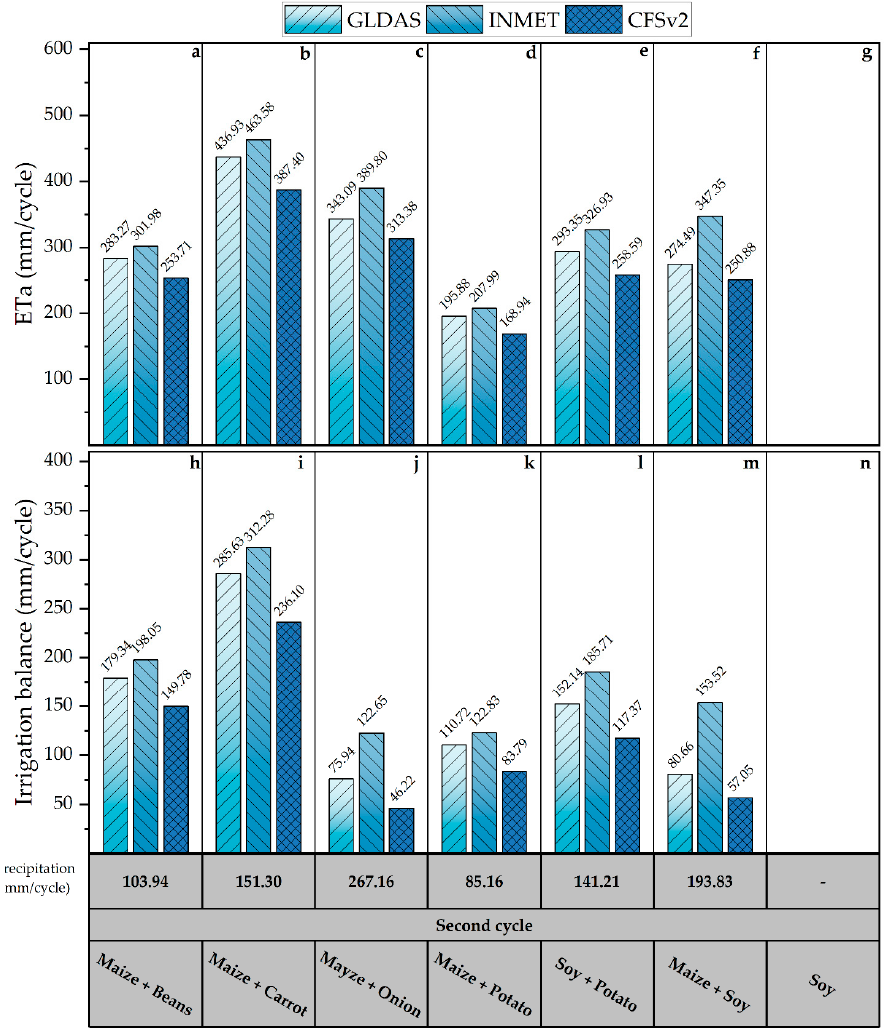
Figure 11. Average accumulated evapotranspiration ( a – g ) and precipitation and irrigation balance ( h – n ) of the second cycle of the classes ( a – n ). The second cycle of the classes is mainly represented by winter crops, such as beans, carrot, onion, and potato. The soy crop in the second cycle is observed in one class (maize + soy). The accumulated precipitation values are represented in the first row of the table below the graphics.